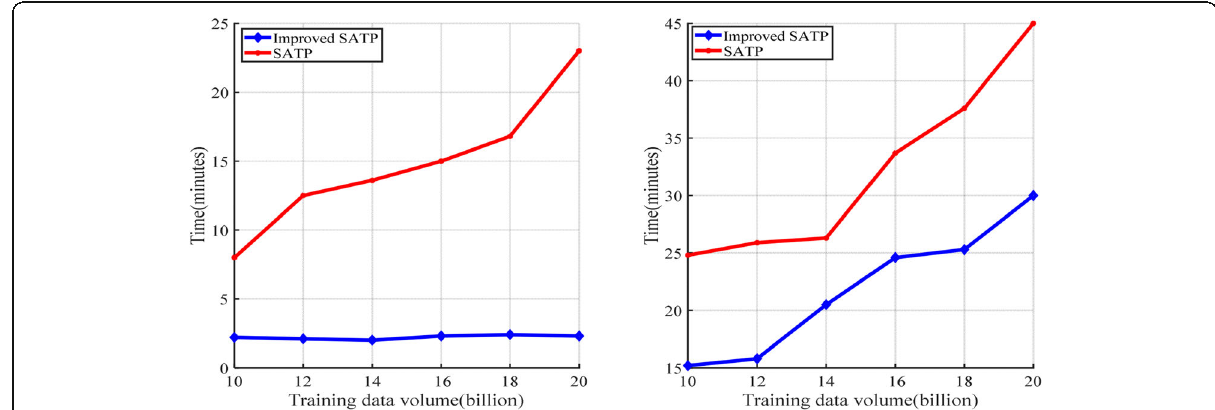
Fig. 7 Time-consuming comparison of original and improved SATP